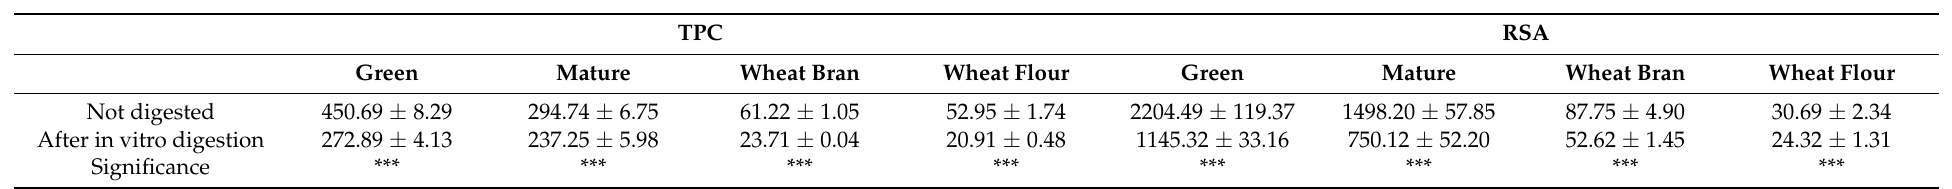
Table 11. Values (mean ± standard deviation; n = 3) of total phenolic content (TPC; mg GAE/100 g DW) and radical-scavenging activity (RSA; µ mol TE/100 g DW) of the extracts obtained before and after in vitro digestion of breads prepared with 8% of Achaak hulls (green and mature), wheat bran, and wheat flour, and results of analysis of